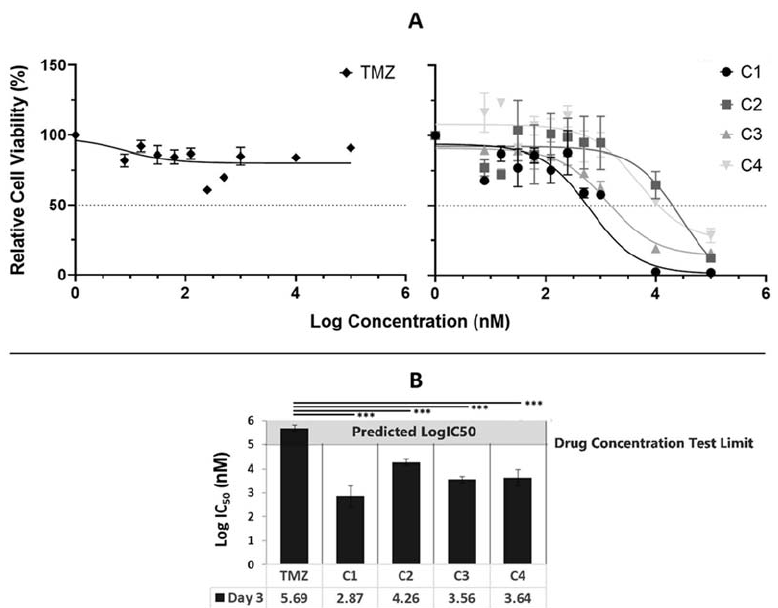
Figure 1. Three-day incubation average ( n = 9) drug cytotoxicity data for TMZ and drug combinations against patient-derived tumour core samples. ( A ) Average ( n = 9) cytotoxicity curves and ( B ) average ( n = 9) LogIC 50 data for nine tumour core samples treated with TMZ, C1, C2, C3 or C4. Significance between the groups is denoted by *** p < 0.001, if no line is drawn p > 0.05 within the